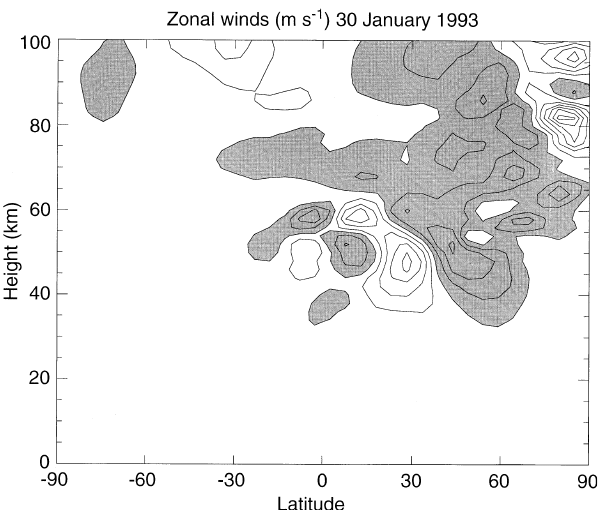
Fig. 7. Zonally averaged di(cid:128)erences in zonal mean winds (ms ) 1 ) from the ESM after 60 days of model integration between solar flux levels ) 1 . Contour intervals are 2 ms ) 1 and of f10.7=210 and 180 wm ) 2 H 2 shading denotes values greater than 1 ms –1